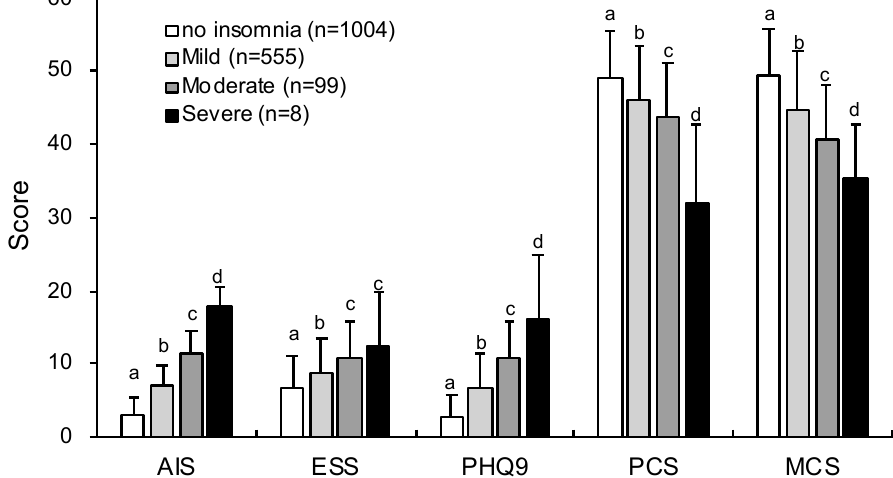
Figure 3. Comparison of categories for insomnia severity according to the ISI on each scale. Different letters indicate significantly different scores between groups ( p < 0.05).